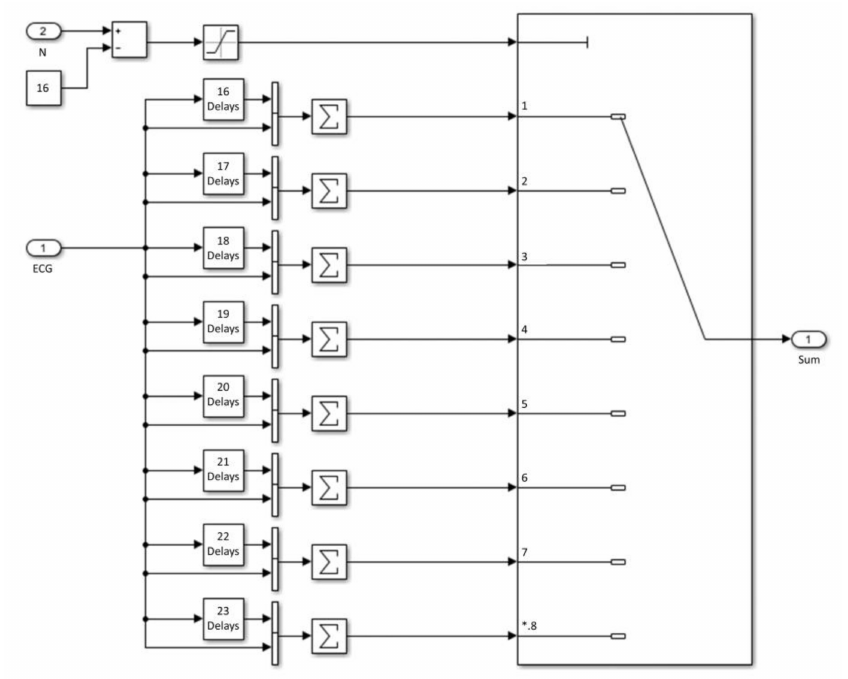
Figure 12. Sum Delay block diagram